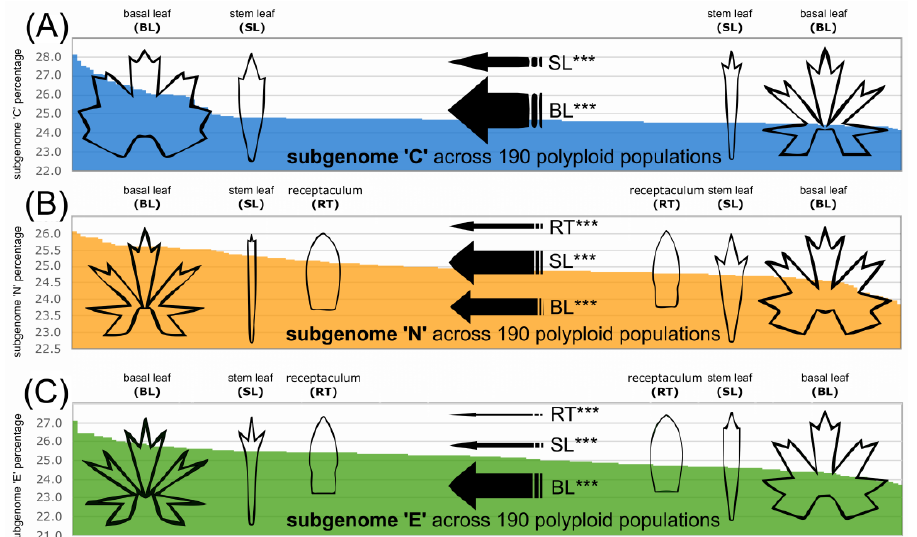
Figure 7. Morphological variation of polyploid apomicts along the gradients of subgenomic (RAD- Seq) contributions of sexual progenitor species. The multivariate multiple regression analyses are based on 190 polyploid apomictic populations. The polyploid morphotypes can be predicted by their genomic composition, namely by the sexual subgenomes predominating in the polyploid genomes. The regression models of shape in relation to genomic background were computed for the gradients of subgenome ‘C’ ( A ), ‘N’ ( B ), and ‘E’ ( C ). The illustrated morphotypes of basal leaves, stem leaves, and receptacles were generated by regression models, and all significant predictions are shown. The thicker the arrow, the stronger the association between trait shape and genomic composition. The coloring of sexual progenitors and clusters follows Figure 2 and [51]. BL = basal leaves; Cluster 1 = RAD-Seq (RADpainter) cluster 1 containing R. cassubicifolius and polyploid apo- mictic relatives; Cluster 2 = RAD-Seq (RADpainter) cluster 2 containing R. flabellifolius , R. marsicus , and R. notabilis and polyploid apomictic relatives; Cluster 3 = RAD-Seq (RADpainter) cluster 3 con- taining R. envalirensis and polyploid apomictic relatives; RT = receptacles; SL = stem leaves. *** = p < 0.001.